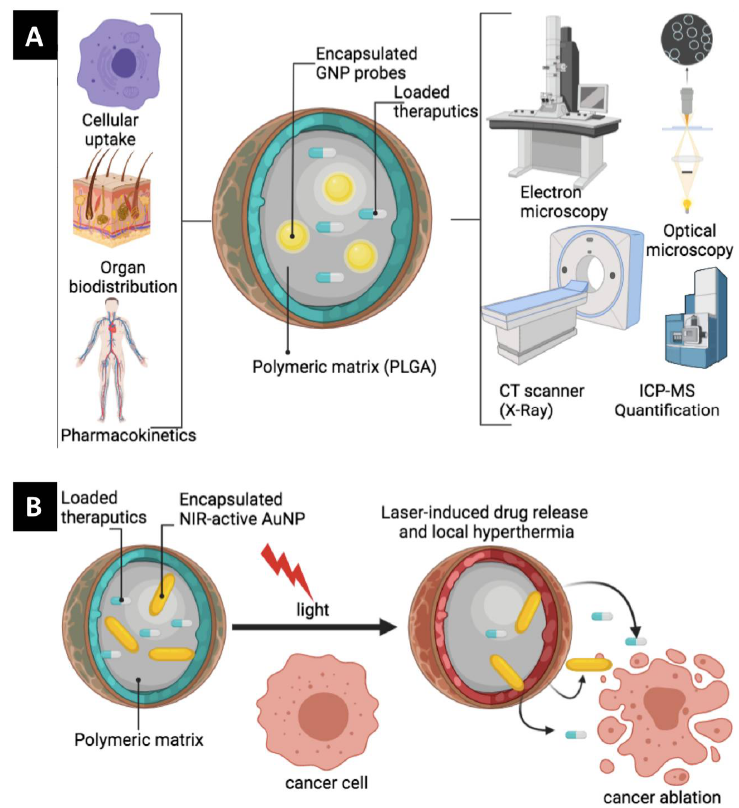
Figure 1. The collective rationale of encapsulating GNP into poly(lactic-co-glycolic acid) (PLGA) nanocarriers: ( A ) Utilizing the optical and electronic properties of GNP to enable the use of various tracking and visualization tools including electron and optical microscopies, ICP-MS and CT-scanning. The labeled PLGA nanocarrier can then be tracked and quantified with accuracy and precision to understand the nano-bio interaction of the PLGA host at the level of cell, tissue and whole organism. ( B ) The photothermal property of encapsulated GNP can be utilized in the development of a light-responsive drug delivery system as well as the synergetic photothermal-chemotherapeutic ac- tivity against cancer.